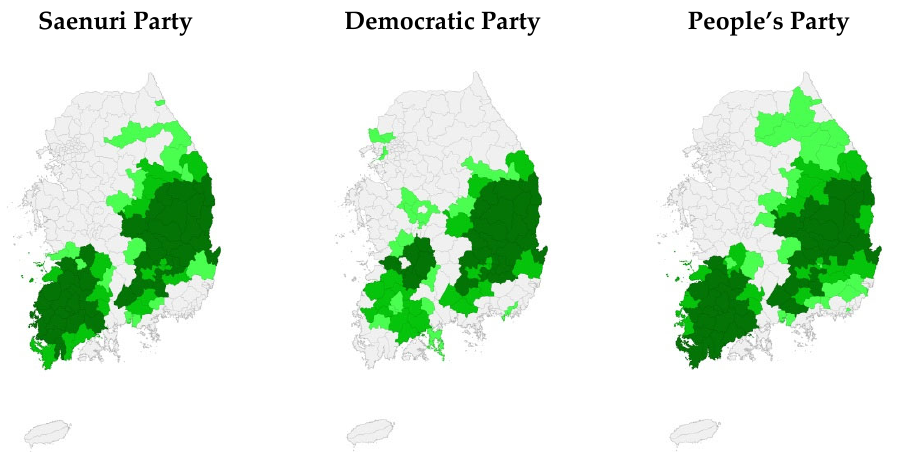
* G statistic in Korean regions. Figure 6. Getis-Ord G ∗ i statistic in Korean i